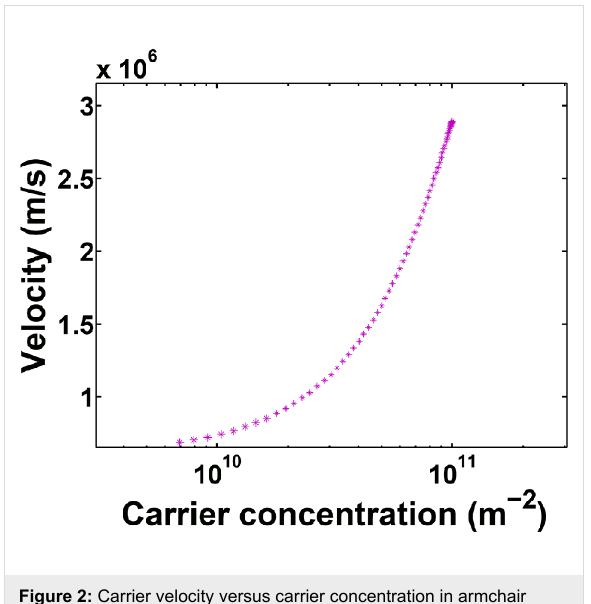
Figure 2: Carrier velocity versus carrier concentration in armchair graphene nanoribbon